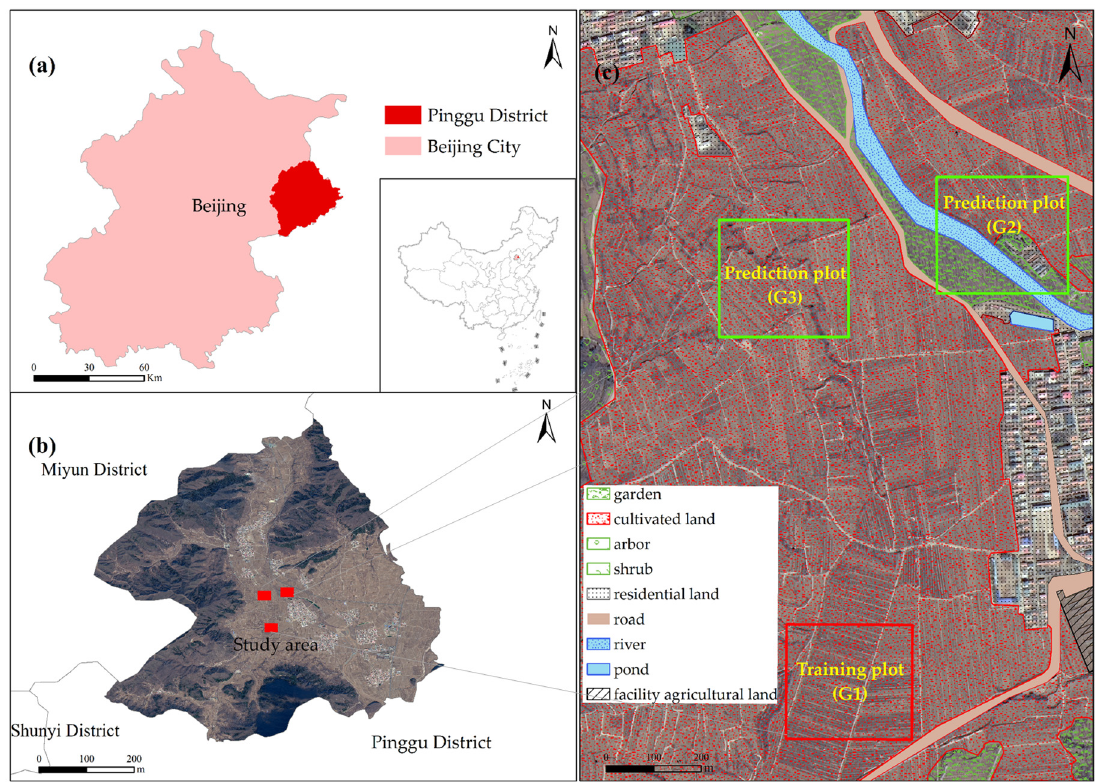
Figure 2. ( a ) Overview of the Pinggu District in Beijing, China; ( b ) study areas in the Pinggu district; and ( c ) a Gaofen-2 image of the study area and field plots, including the training plot (G1) and prediction plots (G2 and G3).